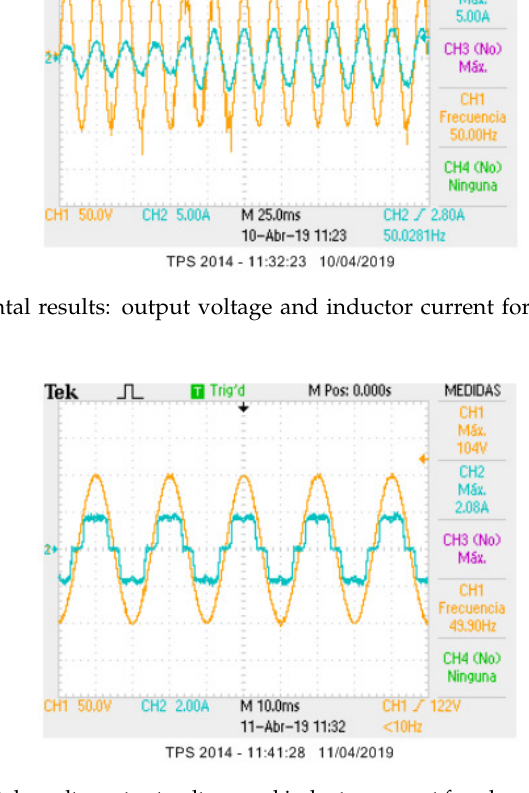
Figure 14. Experimental results: output voltage and inductor current for phase a under a nonlinear